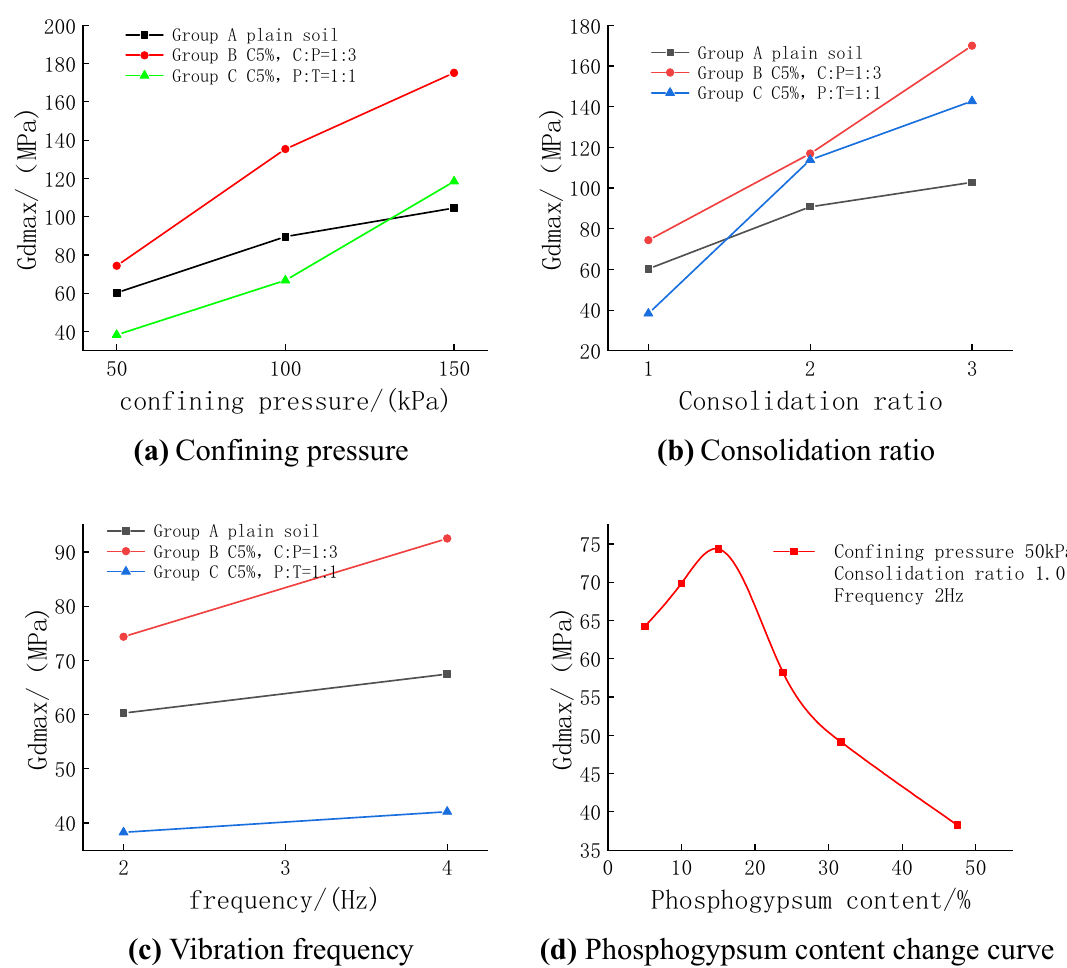
Fig. 12 Variation curve of maximum dynamic shear modulus with confining pressure, consolidation ratio, vibration frequency and phos- phogypsum